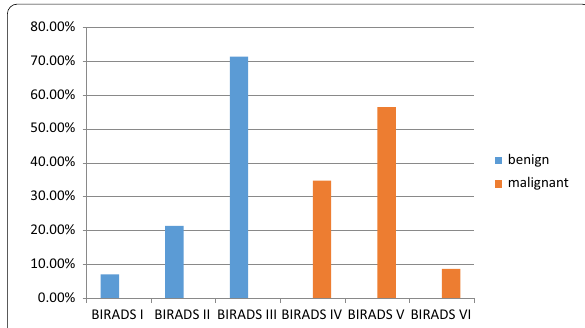
Fig. 2 Correlation between ABUS BIRADS and pathology